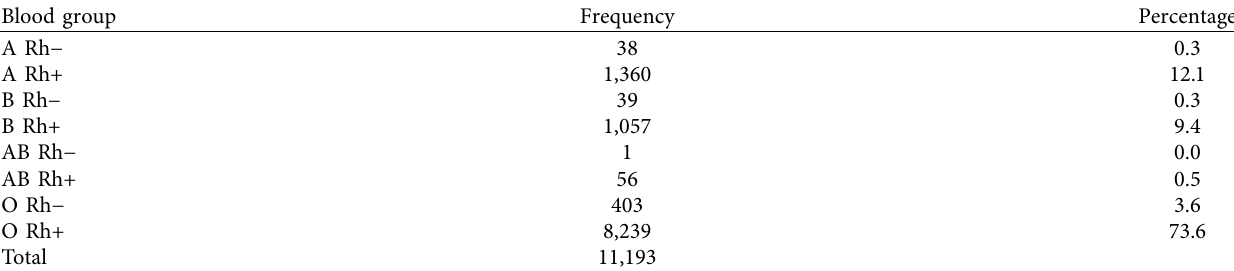
Table 3: Distribution of blood group across persons who donated blood during the study period. Blood group